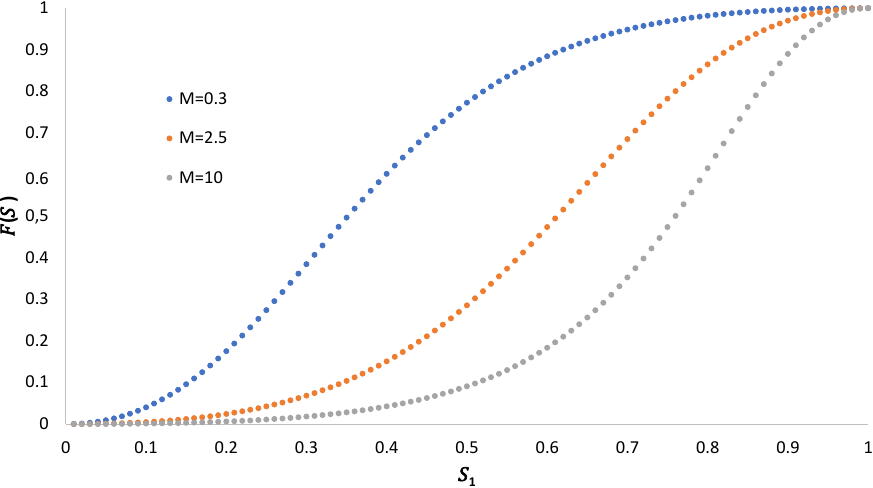
Figure 4. The flow function F as a function of saturation for three mobility ratios. Next, we make Equation (46) non-dimensional by defining the variables x = x (cid:48) t = ut . Dropping the sub-index, we can express Equation (46) as φ L